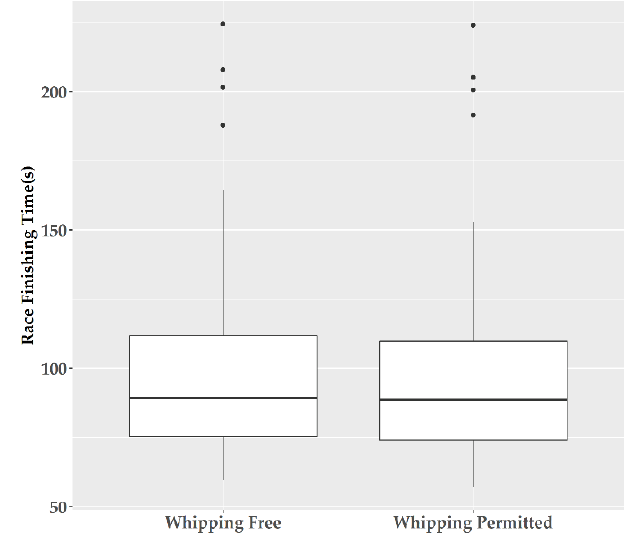
Figure 1. Finishing times for horse races in Great Britain matched for racecourse, distance, class, field and course conditions, with the use of whips permitted and not